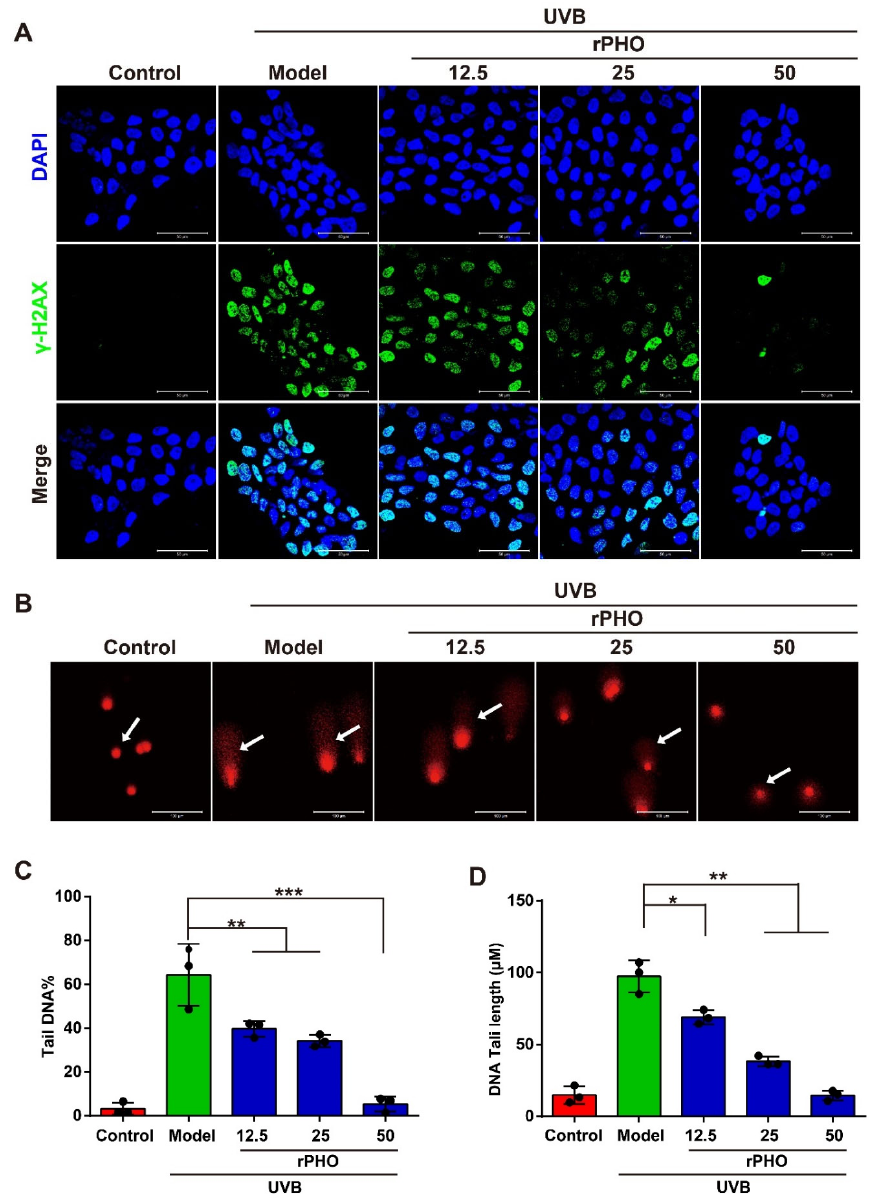
Figure 7. rPHO reduced UVB-induced DNA damage in HaCaT cells. ( A ) DNA damage measured by H2AX phosphorylation ( γ -H2AX). HaCaT cells were treated with rPHO for 24 h after UVB irradiation (2 mJ/cm2), and immunostaining of γ -H2AX in HaCaT cells was performed. Blue: DAPI; green: γ -H2AX. ( B ) Representative alkaline comet assay images. Scale bar = 50 μ m. ( C , D ) Tail DNA and DNA tail length were evaluated using ImageJ. Data are expressed as means ± SD ( n = 3). * p < 0.05, ** p <0.01, *** p < 0.001.